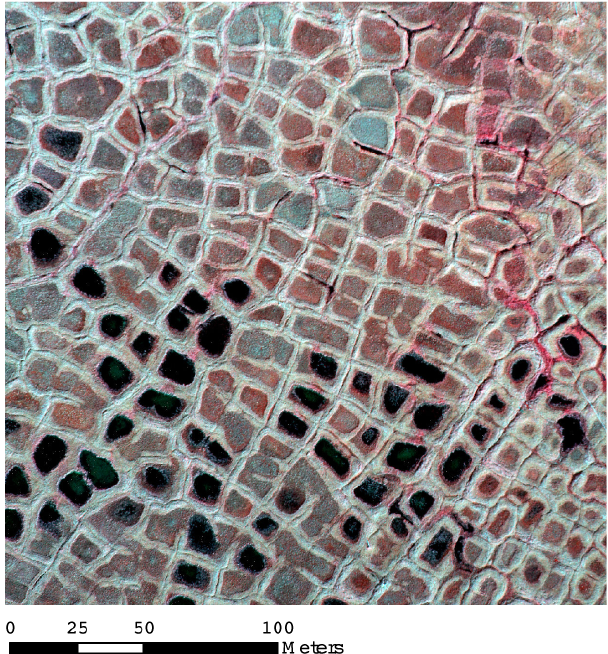
Fig. 1. Color-infrared aerial picture of polygonal tundra on Samoylov Island, Lena river delta, Russia. Dry rims appear light gray, open water appears black. Dark gray and reddish areas indi- cate moist to wet